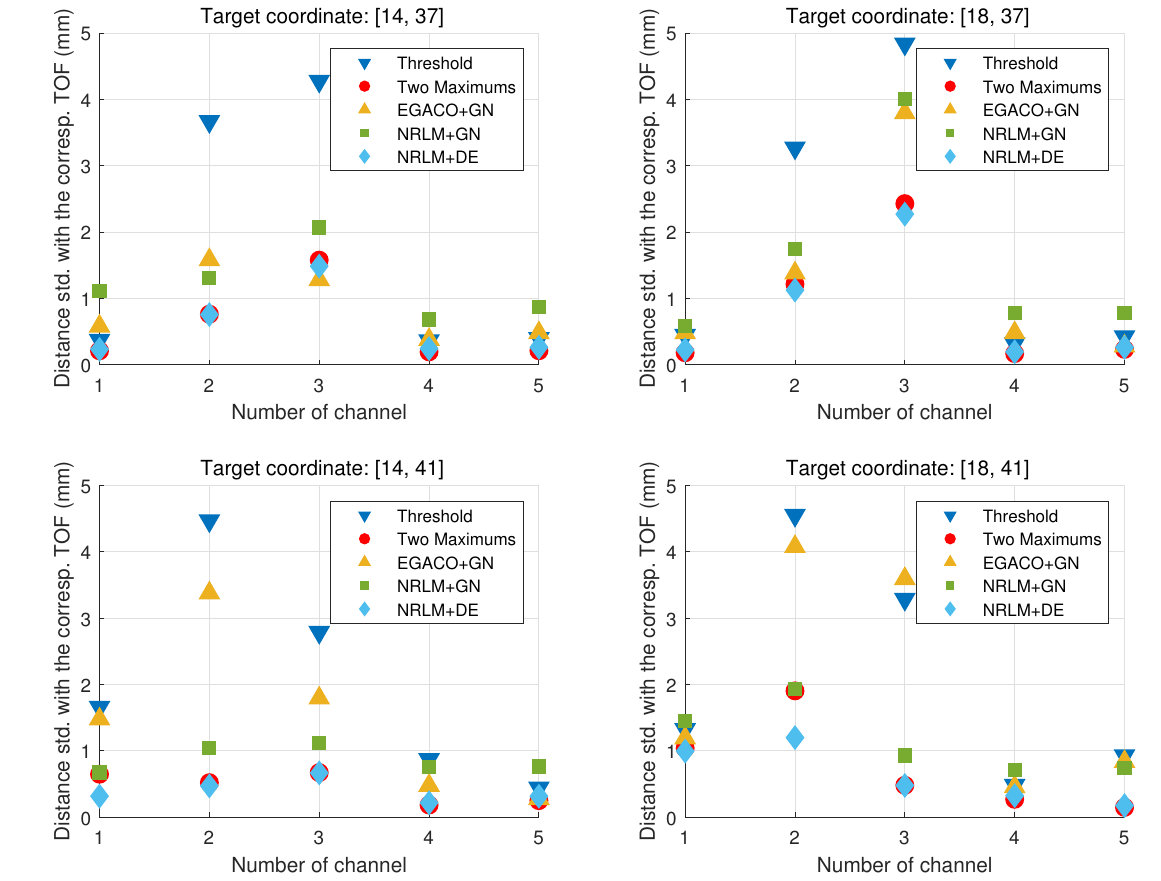
Figure 9. Case 1 (marker pen): Standard deviations of distances with the corresponding TOFs of different methods among five receiver channels. ( (cid:72) ): threshold method; ( • ): two-maximums algorithm; ( (cid:78) ): EGACO algorithm with GN model; ( (cid:110) ): NRLM algorithm with GN model; ( (cid:7) ): NRLM algorithm with DE model. (Vertical coordinate unit: